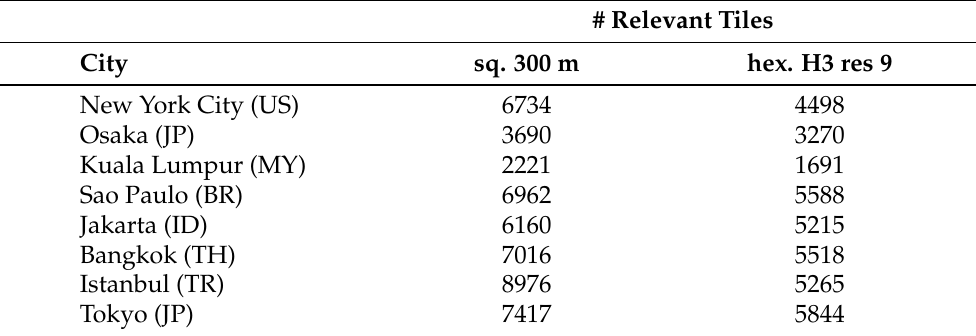
Table 5. A summary of the properties of the 16 weighted spatial tessellations that cover the eight cities considered during the experiments.